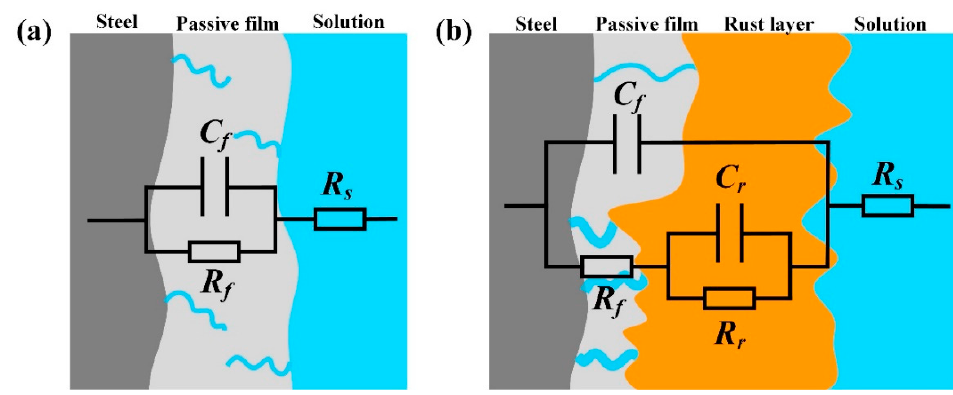
Figure 8. The equivalent circuits used for EIS fitting at different surface conditions: ( a ) fine polished steel and ( b ) the pre-rusted steel.